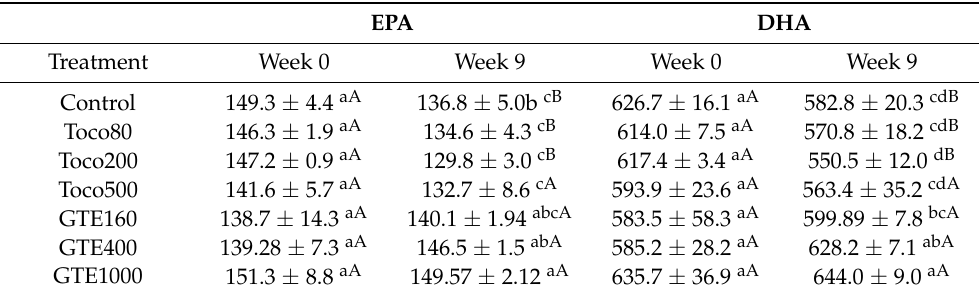
Table 2. The EPA and DHA content (mg/g) of DHA-rich oil at baseline (week 0) and after 9 weeks of storage at 30 ◦